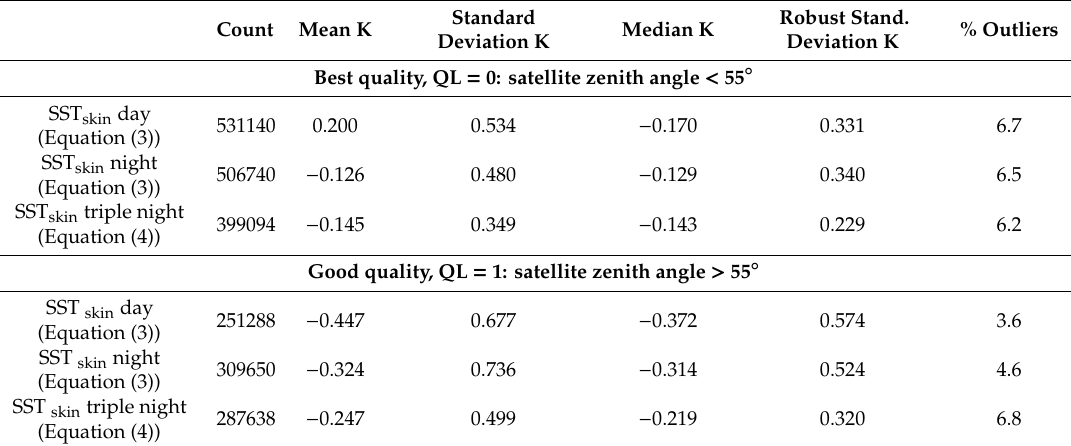
Table 4. Global statistics of di ff erences between VIIRS R2016.0 SST skin and subsurface temperatures from drifting and moored buoys. Matchup observations from October 2012 through September 2016. Standard Robust Stand. Count Mean K Median K % Deviation K Deviation K